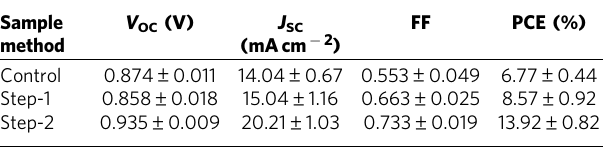
Table 1 | Photovoltaic parameters for printable PSCs fabricated with conventional drop-casting method (control) and moisture-induced crystallization method. Sample method